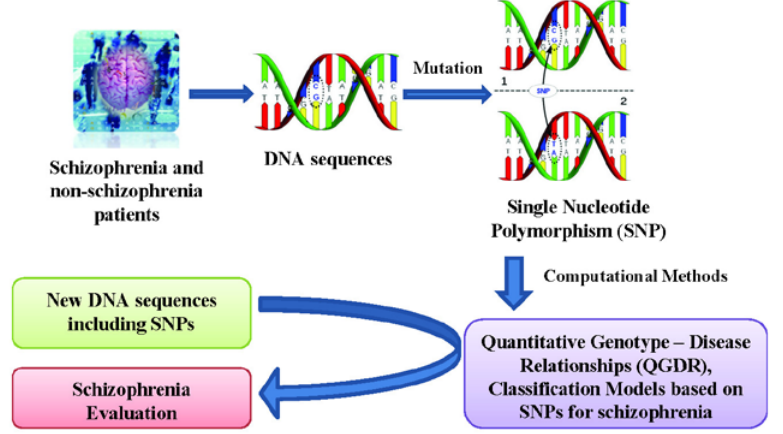
Figure 1. Flow chart of the QGDR model classification between the DNA structure (SNPs) and